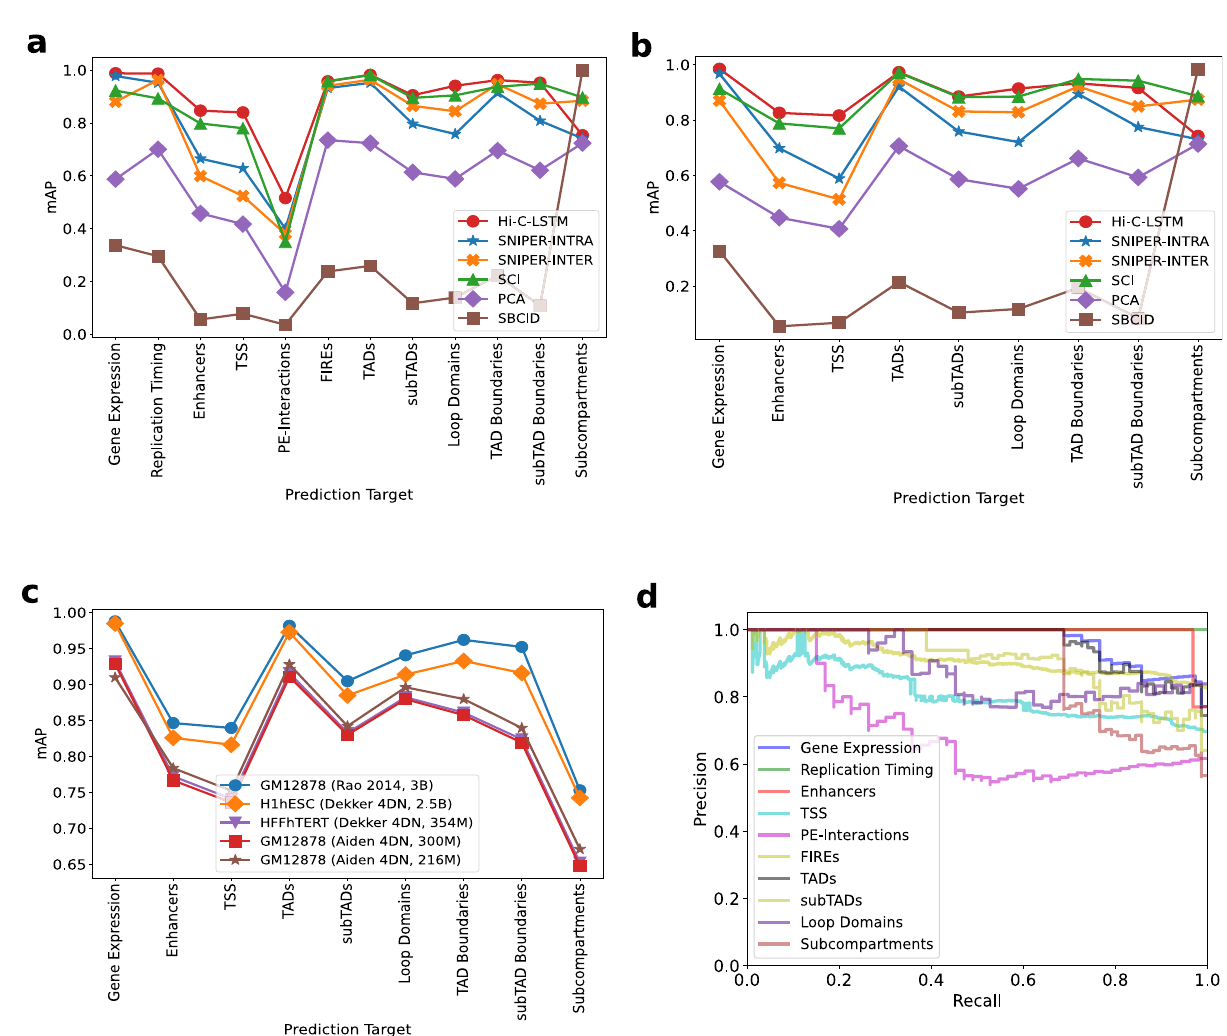
Fig. 4 Genomic phenomena and chromatin regions are classi fi ed using the Hi-C-LSTM representations as input. a Prediction accuracy for gene expression, replication timing, enhancers, transcription start sites (TSSs), promoter – enhancer interactions (PEIs), frequently interacting regions (FIREs), loop and non-loop domains, and subcompartments in GM12878. The y -axis shows the mean average precision (mAP), the x -ticks refer to the prediction targets, and the legend shows the different methods compared with. b Same as ( a ), but for targets in H1-hESC. c mAP using Hi-C-LSTM for targets compared across cell types. d The Precision-Recall curves of Hi-C-LSTM for the various prediction targets in GM12878. The y -axis shows the Precision, the x -axis shows the Recall, and the legend shows the prediction